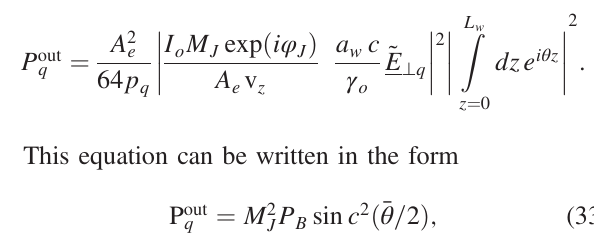
ω =V − k z ¼ z w (dashed line) and the dispersion curve